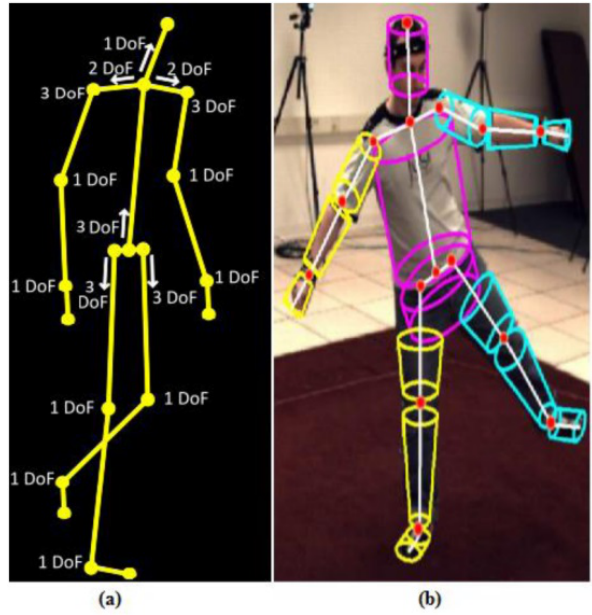
Fig. 9 Movement differences of the skeleton model.